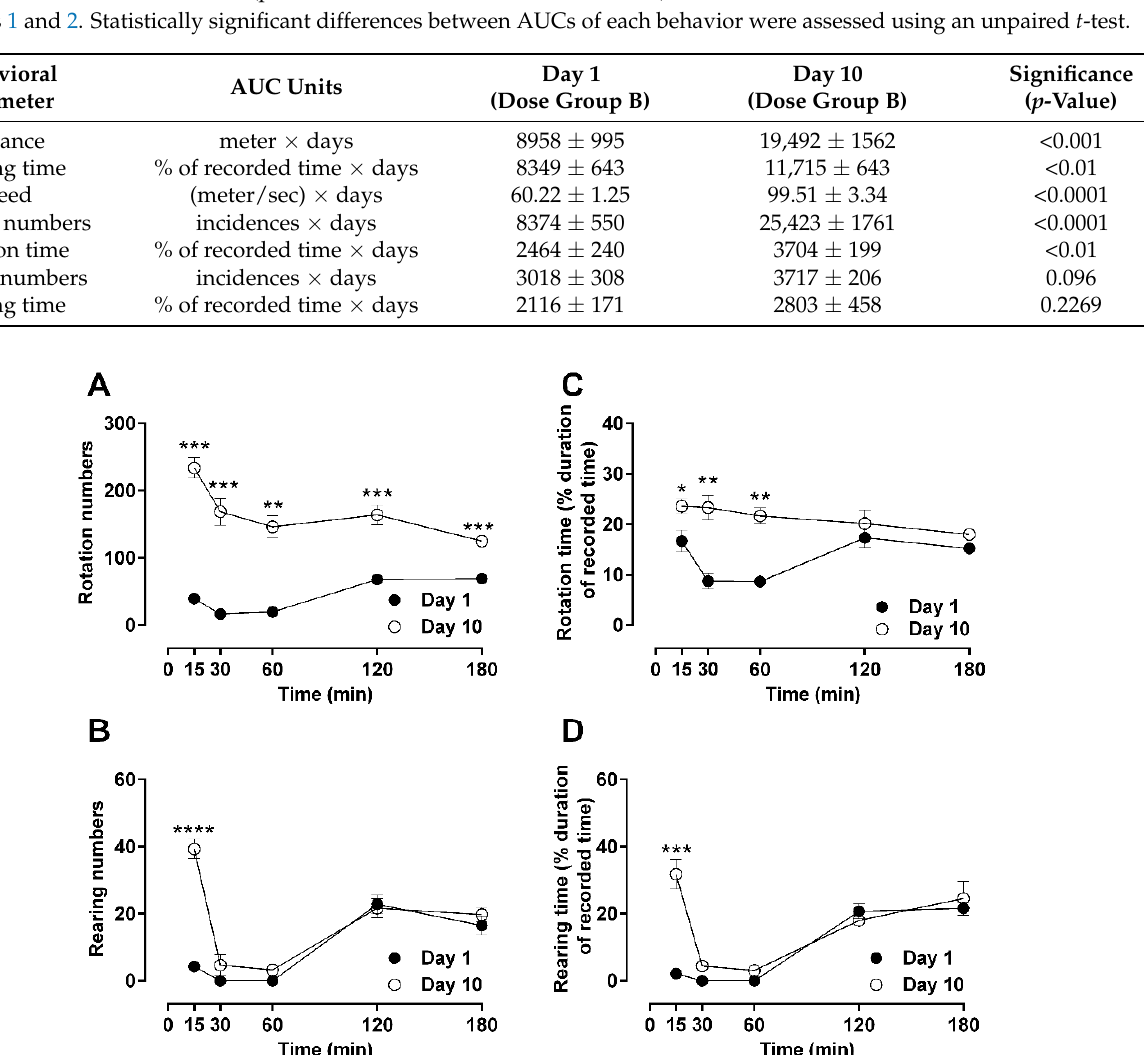
Figure 2. Time-resolved advanced locomotor activity (rotation and rearing) after repeated morphine administration (10 mg/kg, b.i.d. over 10 days). Open-field turning and rearing activities after a single subcutaneous injection of morphine on day 1 or day 10 were measured in male Sprague–Dawley rats. Activities of treated animals were measured as rotation numbers ( A ), rearing numbers ( B ), rotation time ( C ), and rearing time ( D ) over a period of 180 min. Statistical significance ( p < 0.05) at a specific time-point against the effects of day 1 is shown as * p < 0.05, ** p < 0.01, *** p < 0.001, and **** p < 0.0001 and was calculated using unpaired t -test. Values are presented as mean ± SEM ( n = 6 animals per group). Error bars are sometimes too small to be visible. The behavioral differences between day 1 and day 10 are shown as the differences in their area under the curves (AUC) in Table 1, which indicates that differences were observed in rotation, but not in rearing